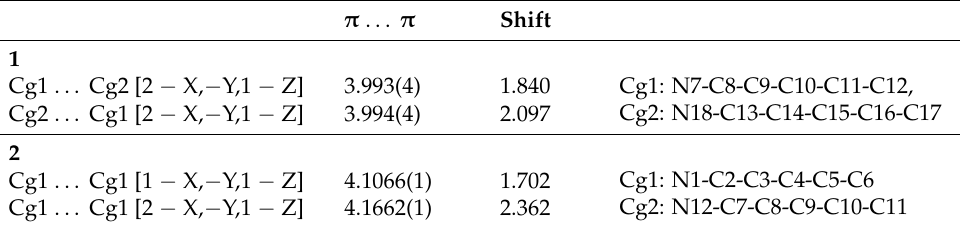
Table 1. π . . . π interactions for 1 and 2 [Å].